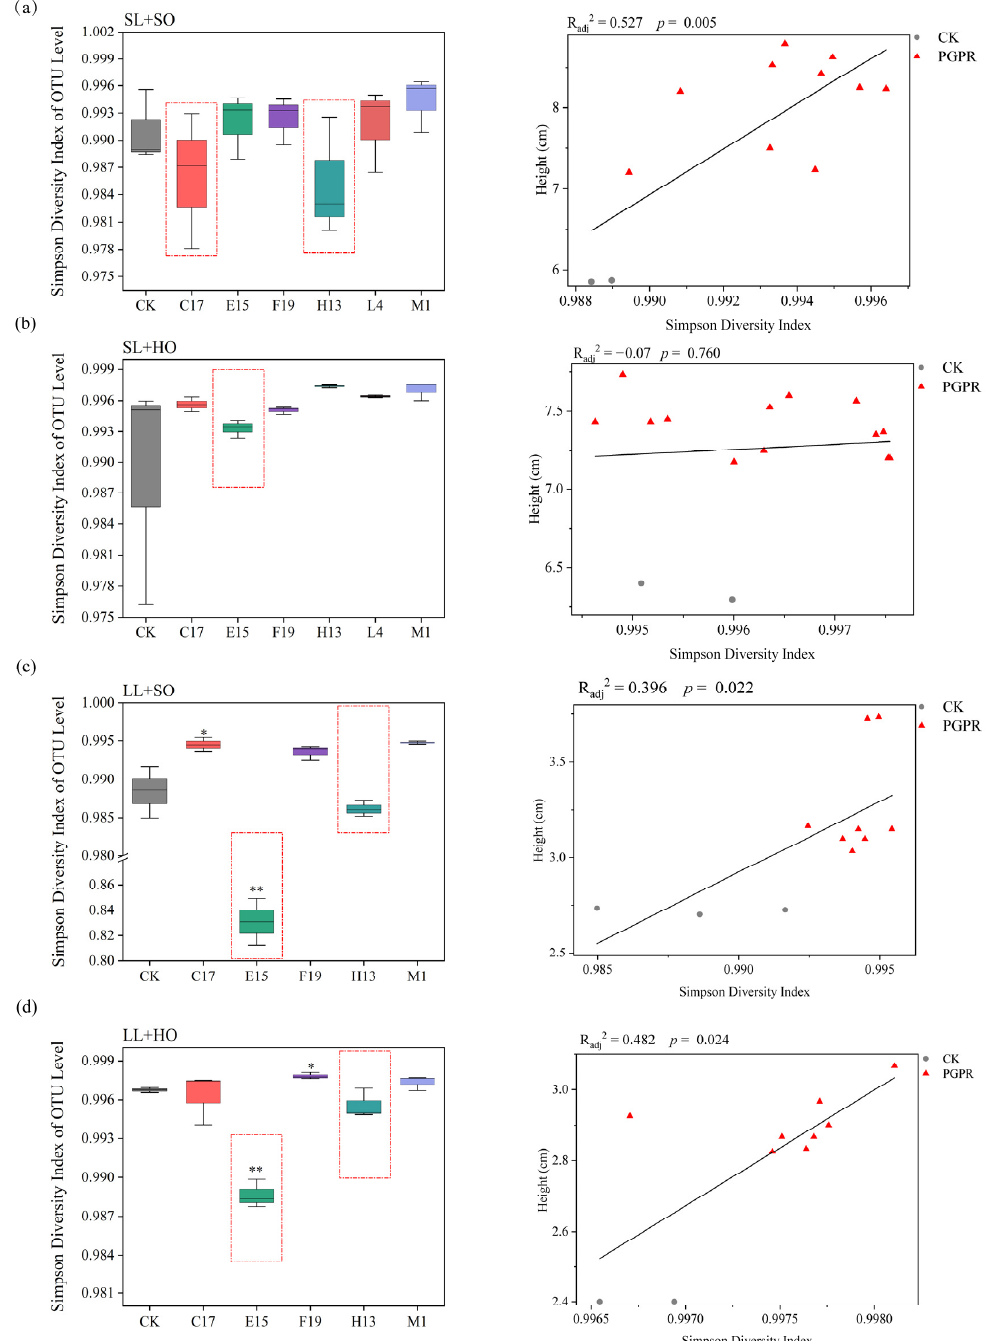
Figure 3. Rhizobacterial Simpson diversity index and its correlations with shoot height of V. natans under four stress conditions; ( a ) Suitable light intensity and suitable sediment organic matter load (SL + SO); ( b ) Suitable light intensity and high sediment organic matter load (SL + HO); ( c ) Low light intensity and suitable sediment organic matter load (LL + SO); ( d ) Low light intensity and high sediment organic matter load (LL + HO). CK: non-inoculation control; C17, E15, F19, H13, L4 and M1 present the inoculation treatments with the corresponding strains. Asterisk indicates significant difference between CK and the inoculated group (* p < 0.05, ** p < 0.01, Student’s t -test). Three replicates of each treatment were used for bacterial 16S rRNA gene